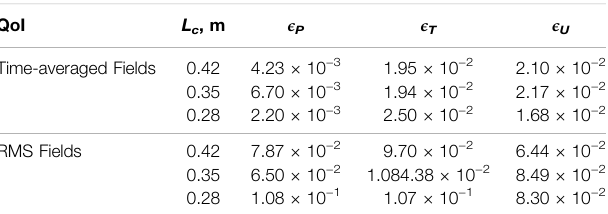
TABLE 4 | Comparisons of the errors in predicting time-averaged and RMS fi elds of pressure ( P ), temperature( T ), and axial velocity ( U ) using the framework corresponding to Figures 7D-H with adaptive-basis ROMs for the single-injector combustor with different combustor lengths ( L c ). QoI L c , m  P  T  U Time-averaged